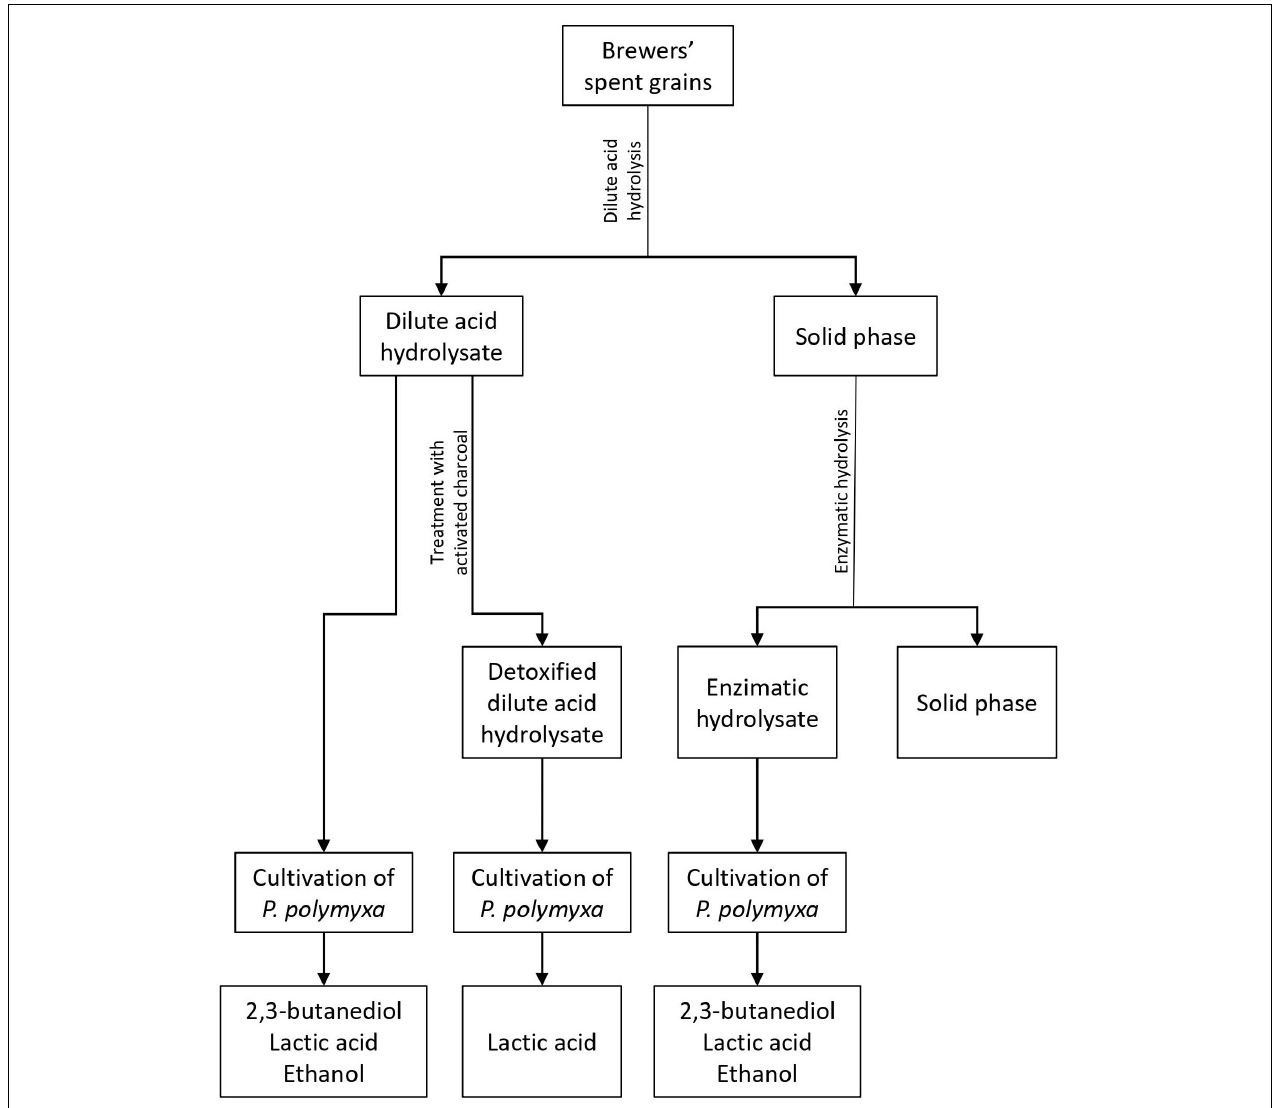
FIGURE 1 | Graphical representation of plan and performance of